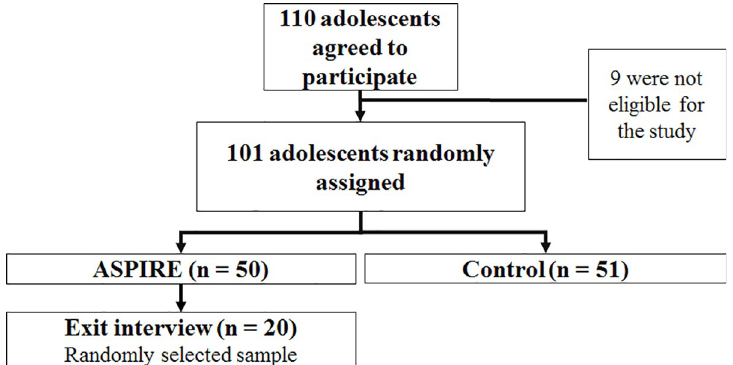
Fig 3. Study flow diagram leading to the exit interview. ASPIRE indicates the main intervention; the control condition involves a text-based version of the main health information related to nicotine and tobacco, presented on the computer